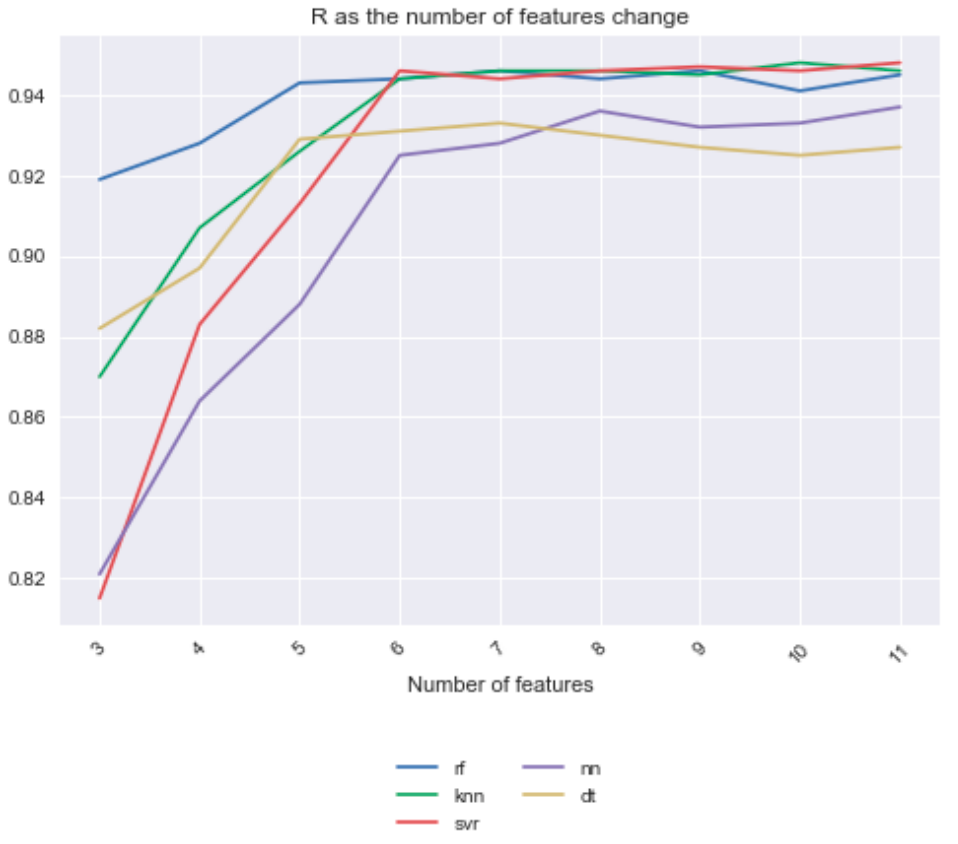
78 Table 2. The classification trees split the data into these classes.